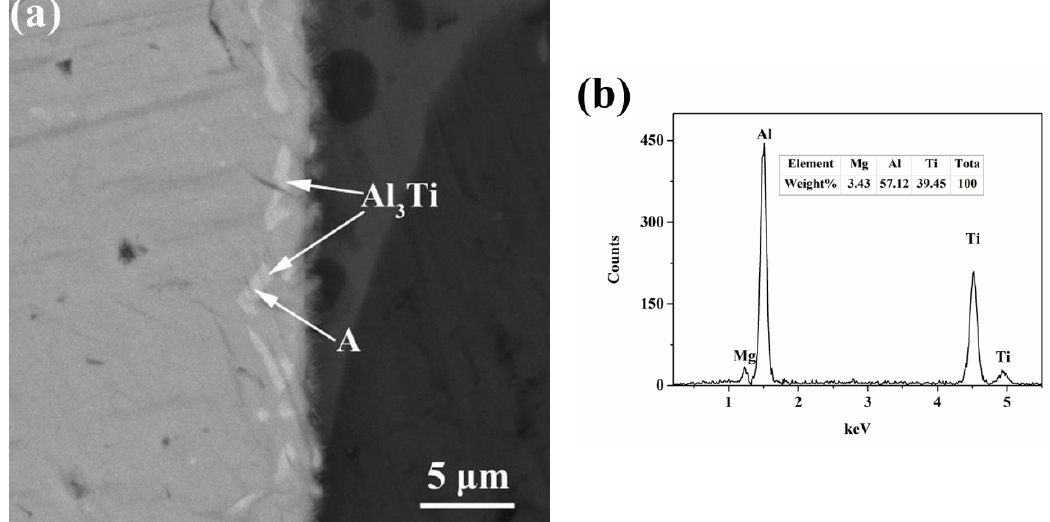
Figure 4. ( a ) The high magnification image of the interface between Mg-9Al matrix and Ti rob obtained after 60 min at 700 °C, ( b ) Energy-dispersive spectroscopy (EDS) result of the point A.